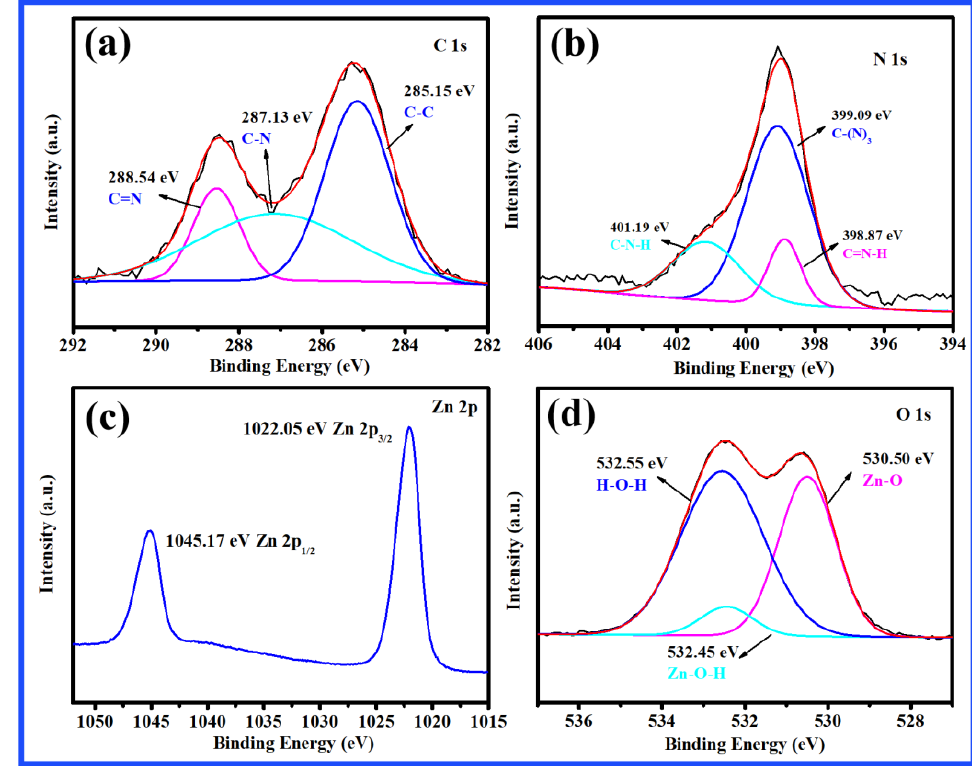
Figure 2. XPS spectra of 10 wt.% CN-200/Z-500: ( a ) C 1s; ( b ) N 1s; ( c ) Zn 2p; ( d ) O 1s.